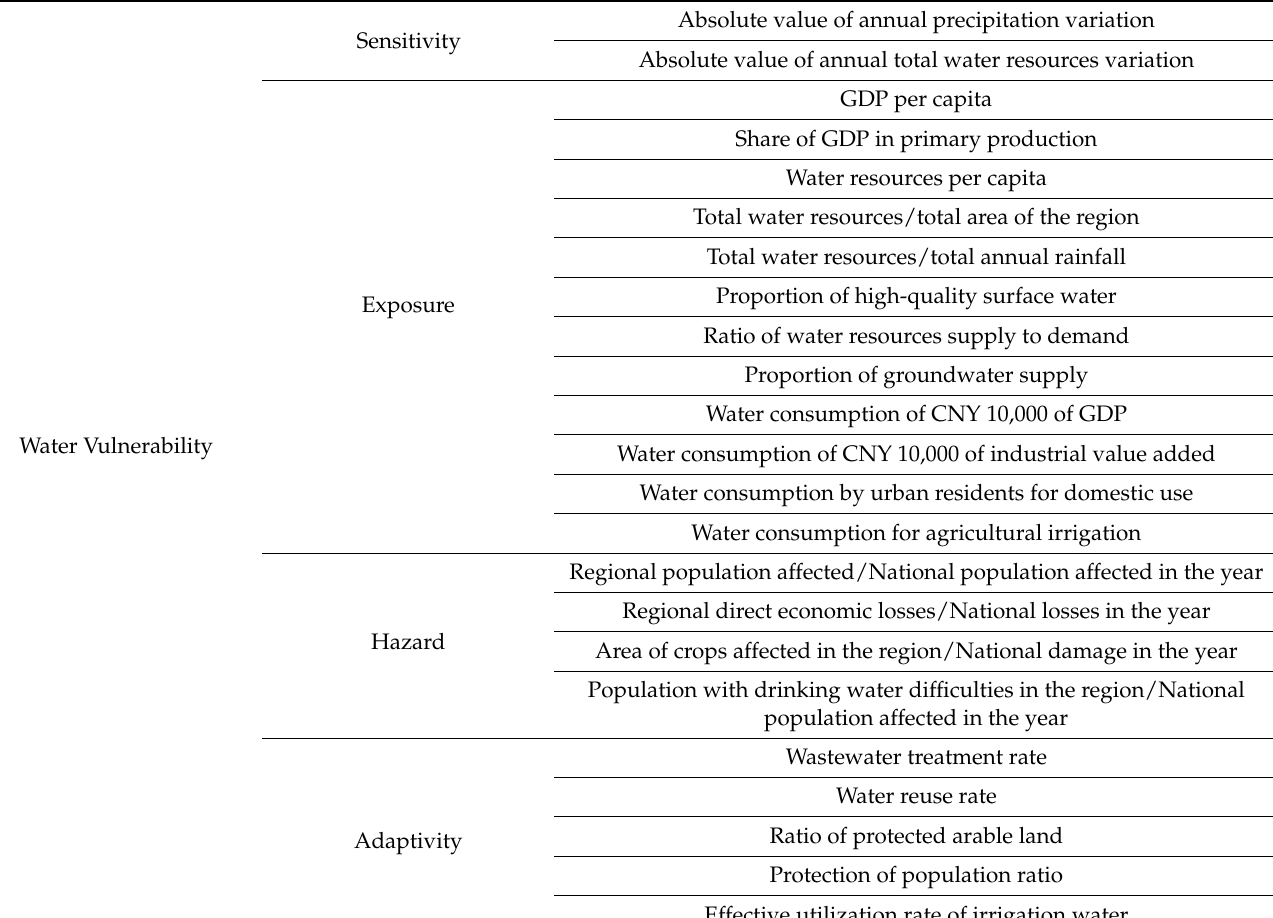
Table 1. The measurement of water